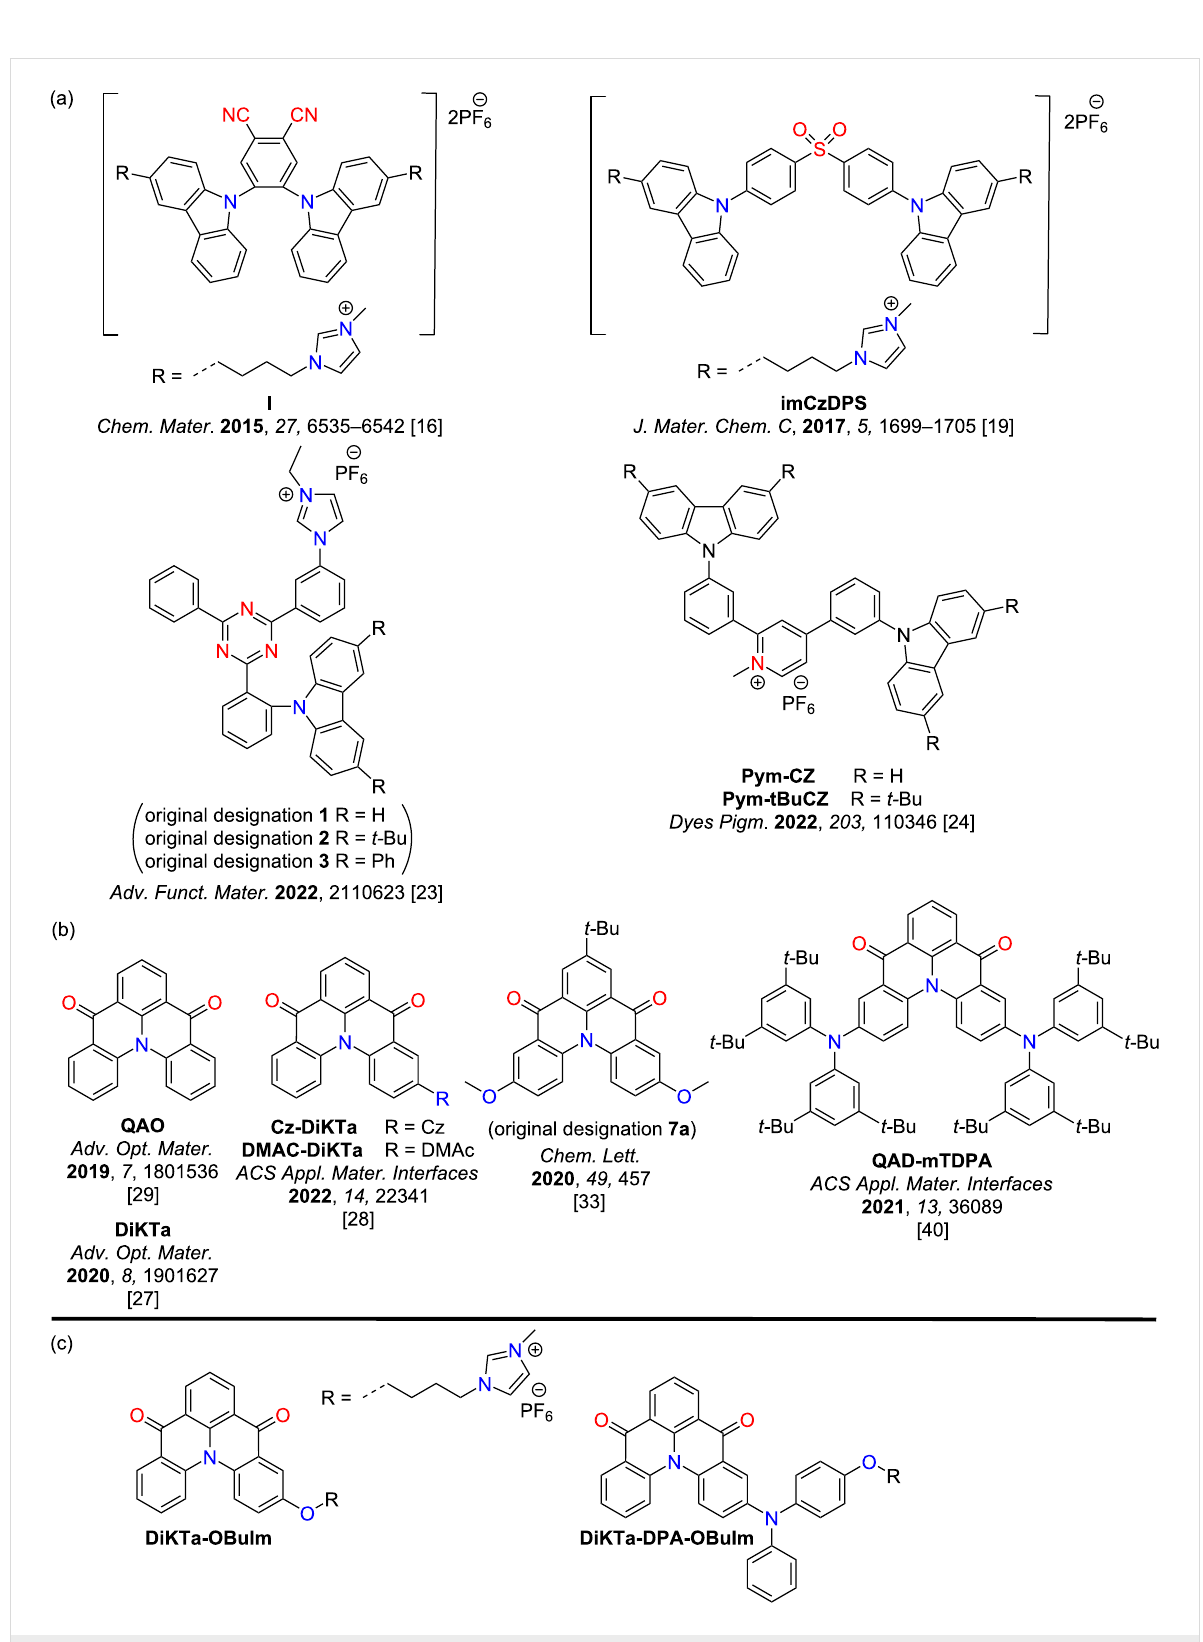
Figure 1: Chemical structures of (a) reported ionic TADF emitters for LEECs, (b) the MR-TADF emitter DiKTa and selected derivatives, and (c) the ionic emitters in this